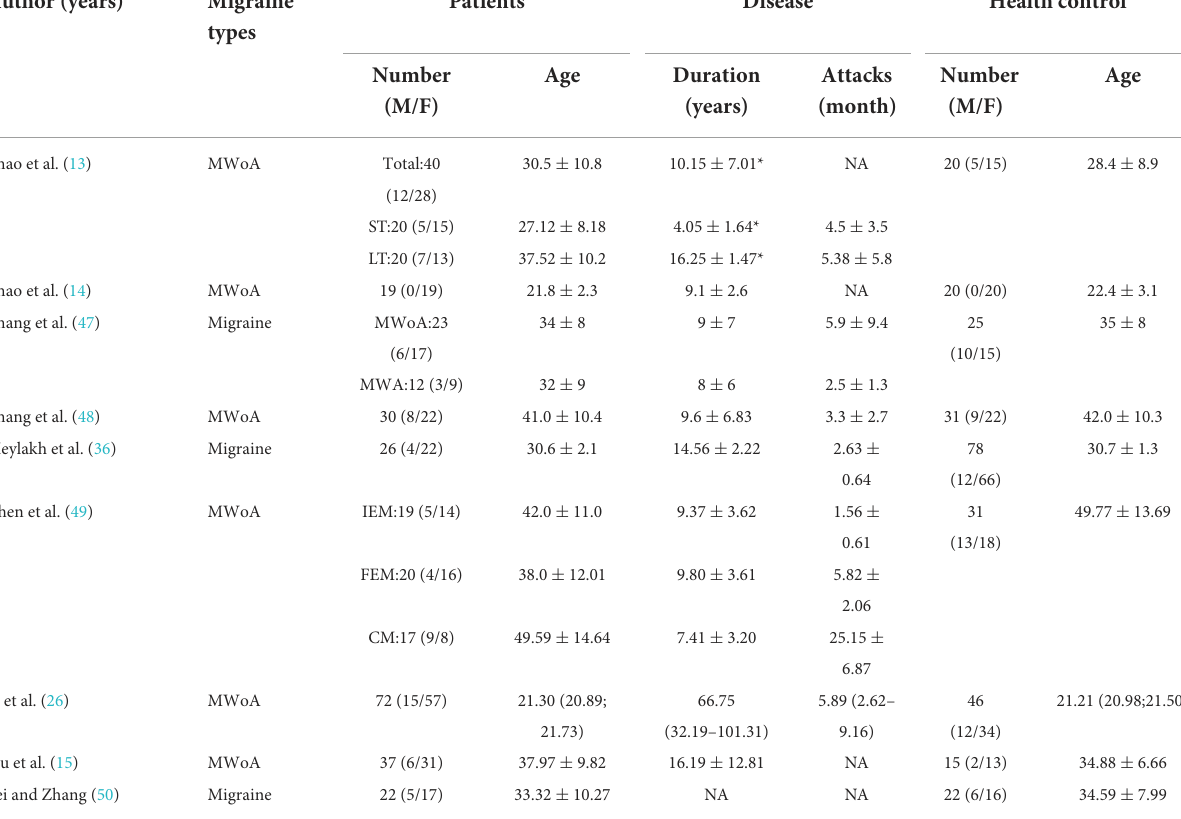
TABLE 3 Demographic and clinical characteristics of migraine in the ReHo